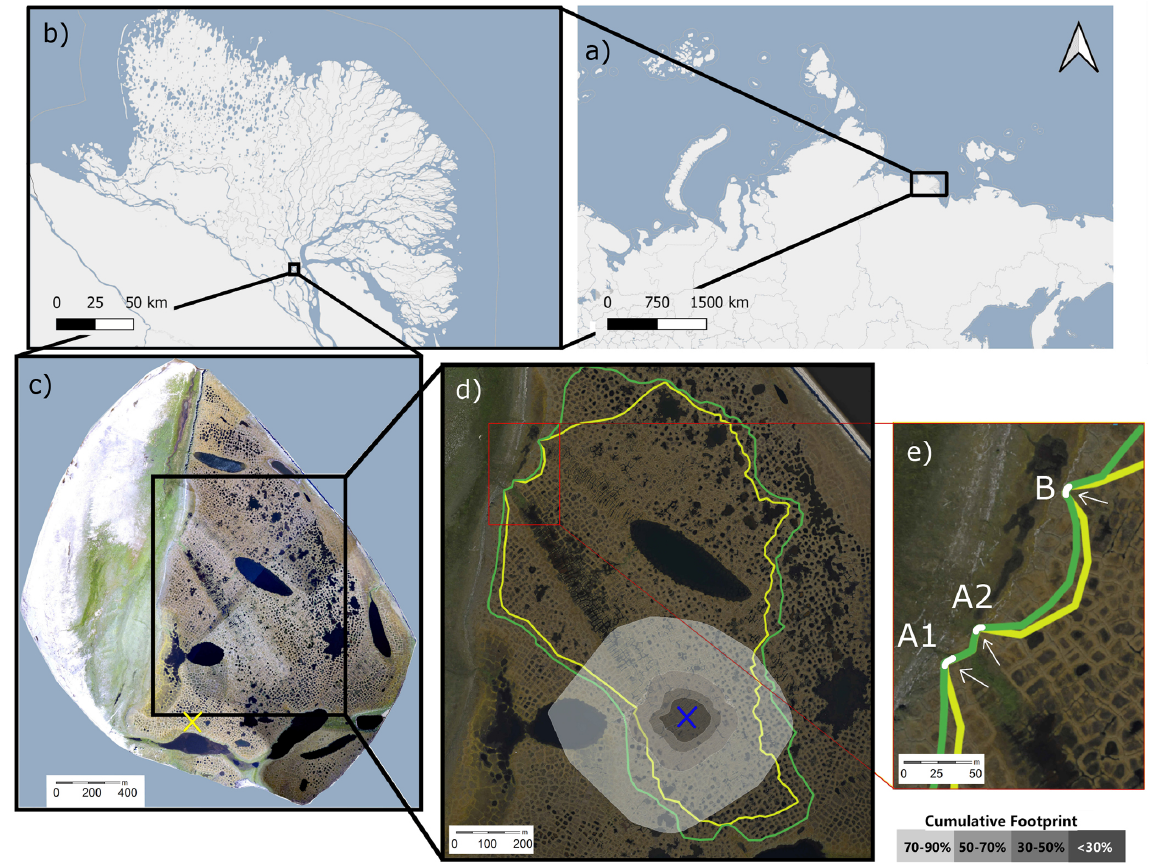
Figure 1. Top: map of northern Russia (a) and the Lena River delta (b) . Bottom: map of Samoylov Island (c) with the maximum (green) and minimum (yellow) catchment size (d) . The blue cross in (d) marks the eddy covariance tower’s location, and the cumulative footprint is shown in gray shades. Of the flux, 30% likely originated from within the dark gray area, 50% from within the medium dark gray area, 70% from within the medium light gray area, and 90% from within the light gray area. The yellow cross in (c) denotes the location of the meteorological station with the active layer depth observations. Panel (e) shows the locations of outflows A 1 , A 2 , and B. Map data from © OpenStreetMap contributors 2020, distributed under the Open Data Commons Open Database License (ODbL) v1.0 (a, b) and modified after Boike et al. (2012b) ( c, d, e